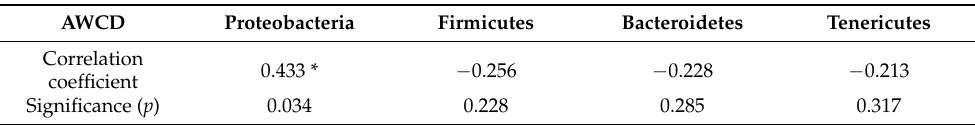
Table 3. Correlation analysis between the AWCD and the relative abundance of dominant intestinal Table 2. Correlation analysis between mantle length of the dwarf-form populations of Sthenoteuthis bacteria at the phylum level. Mantle Length